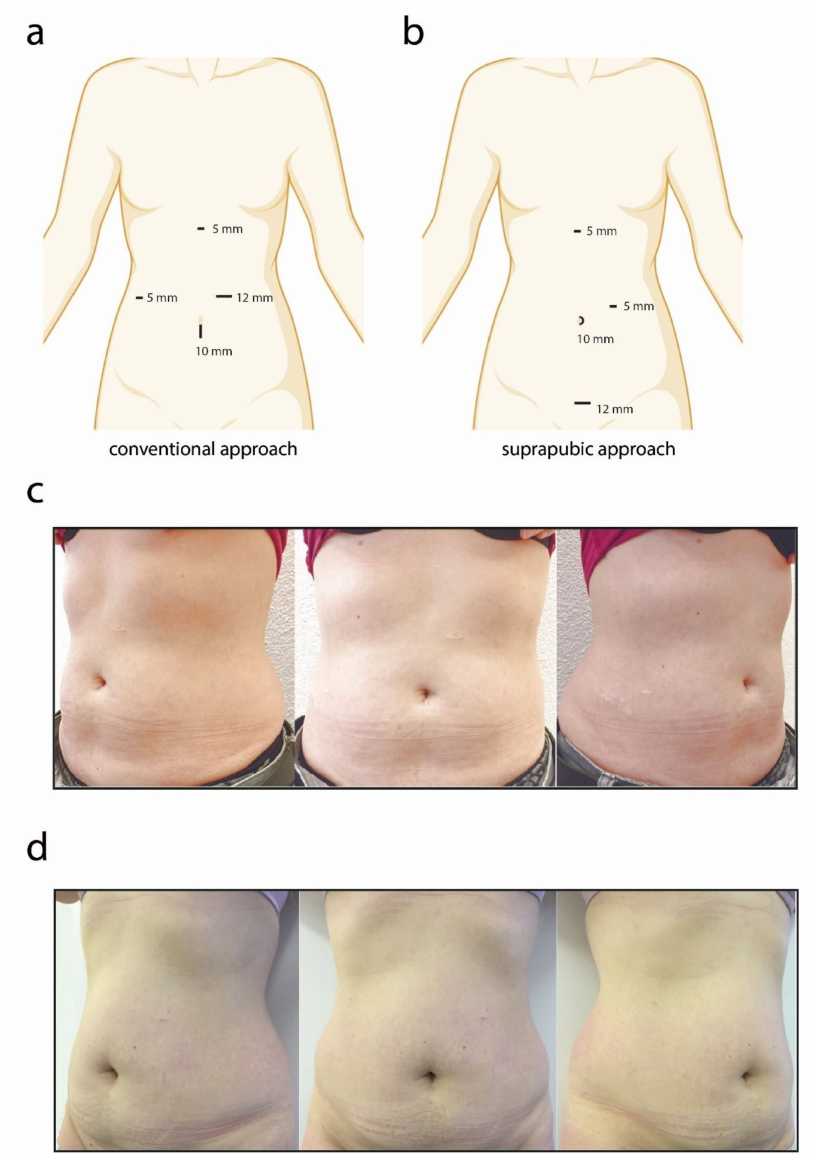
Figure 1. Schematic representation of the trocar positions in the abdomen in the conventional ( a ) and suprapubic ( b ) approach. Representative photographs of the SA follow-up six months postoperatively, conventional ( c ) and suprapubic approach ( d